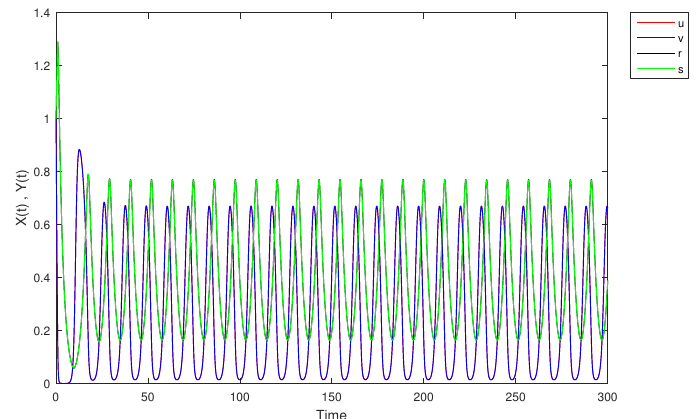
Figure 32. The solution of (14) at α = 0.0 for a short time period.